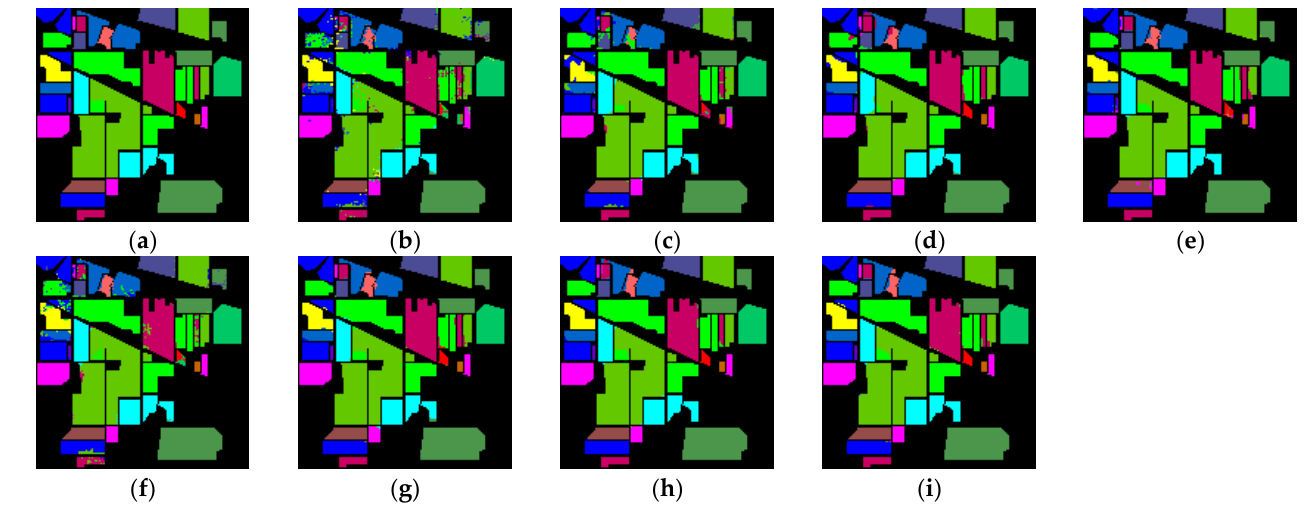
Figure 8. Classification maps generated by all of the competing methods on the Indian Pines data with 10% training samples; ( a ) is ground truth map, and ( b – i ) are the results of Baseline, 3DCNN, SSRN, HybridSN, ViT, 3D_Octave, OctaveVit, SATNet, respectively.